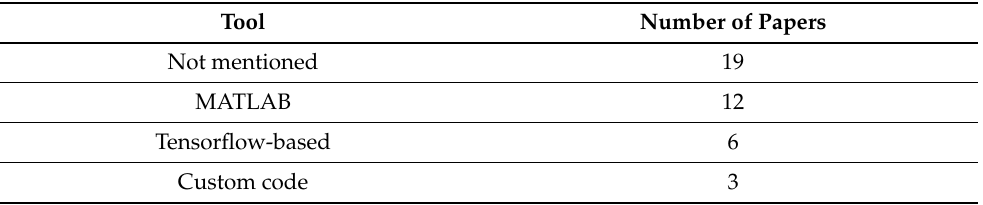
Table 6. Tools used in the reviewed